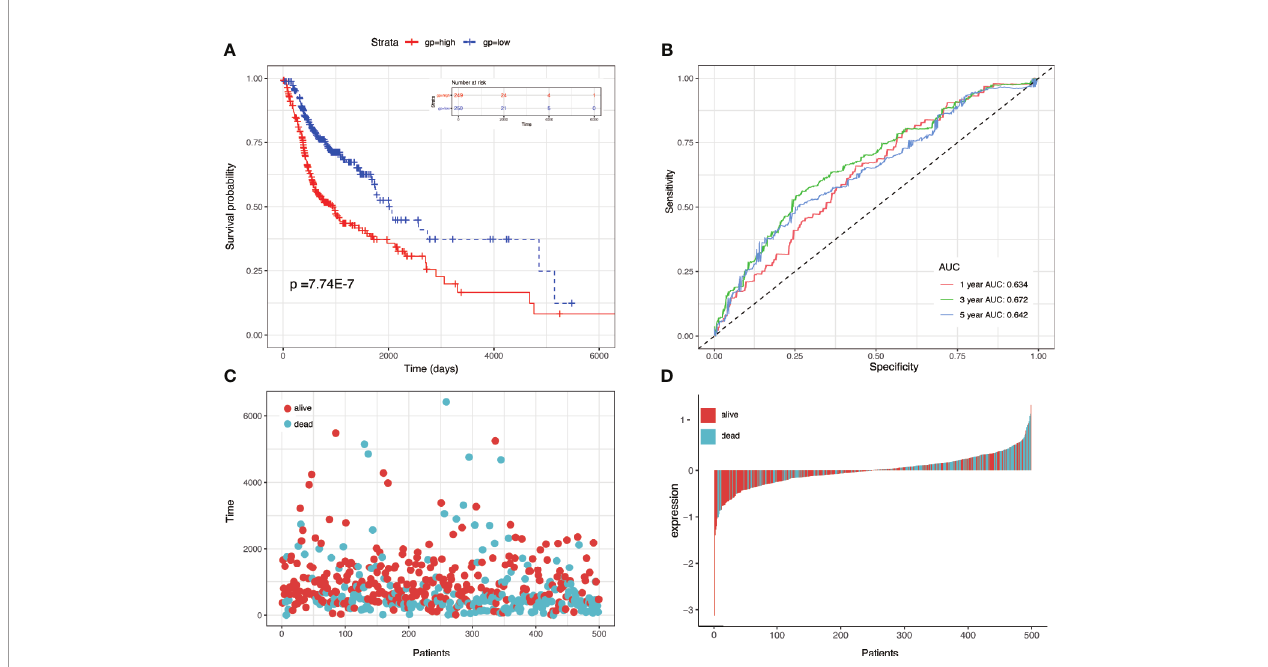
FIGURE 2 | KM survival, risk score by eight-gene signature and time-dependent ROC curves in the TCGA-HNSC training set. (A) KM survival analysis between high- and low-risk samples in TCGA-HNSC. (B) Time-dependent ROC curve for OS of TCGA-HNSC; the AUC was assessed at 1, 3, and 5 years. (C) Relationship between survival time (day) and risk score rank. (D) Relationship between survival status and risk score